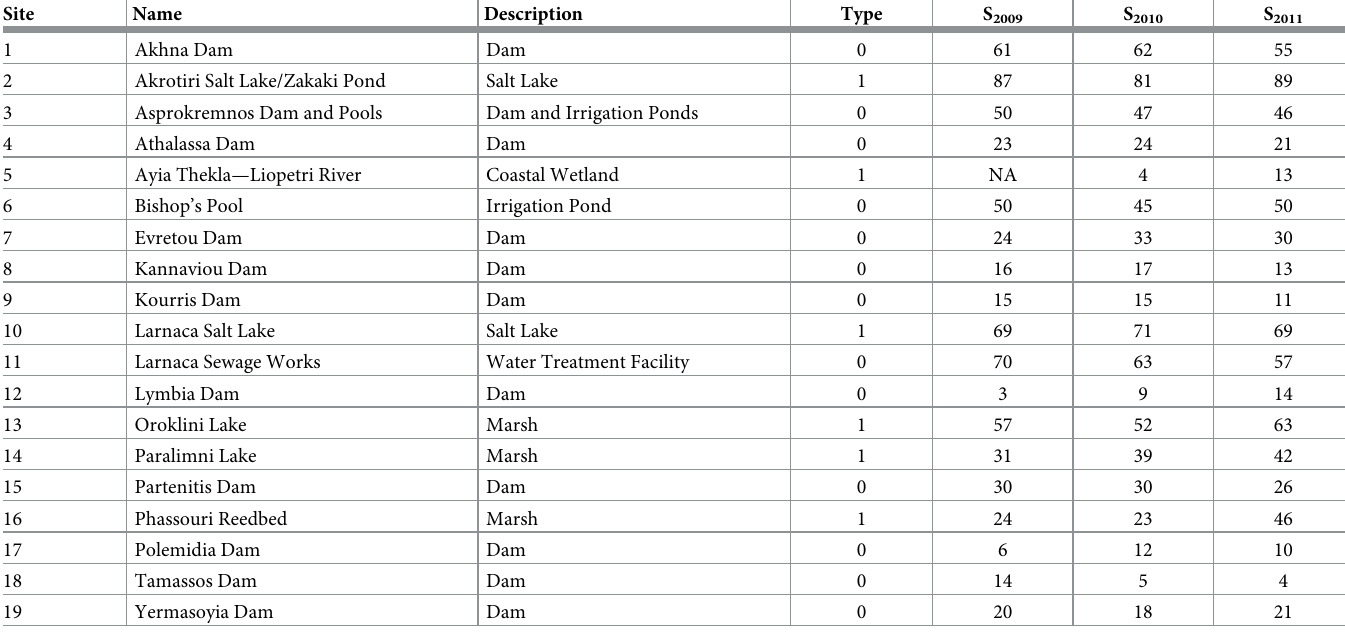
Table 1. List of the wetlands included in the study, along with a description of their type (0 = Artificial, 1 = Natural) and their cumulative bird species richness (S) in 2009, 2010, and 2011. Please note that site 5 (Ayia Thekla–Liopetri) was only surveyed in 2010 and